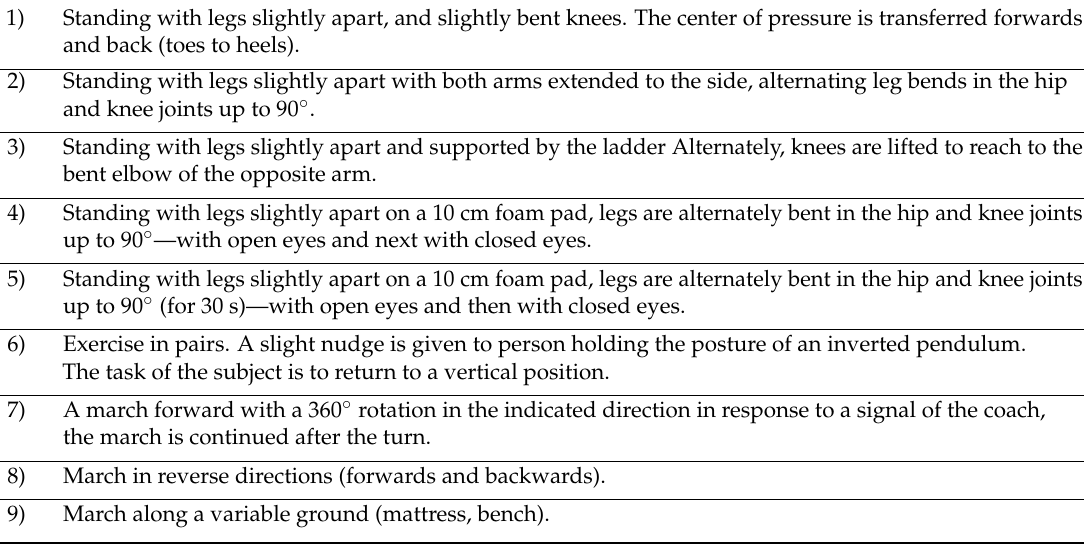
Table 2. Details of balance exercise